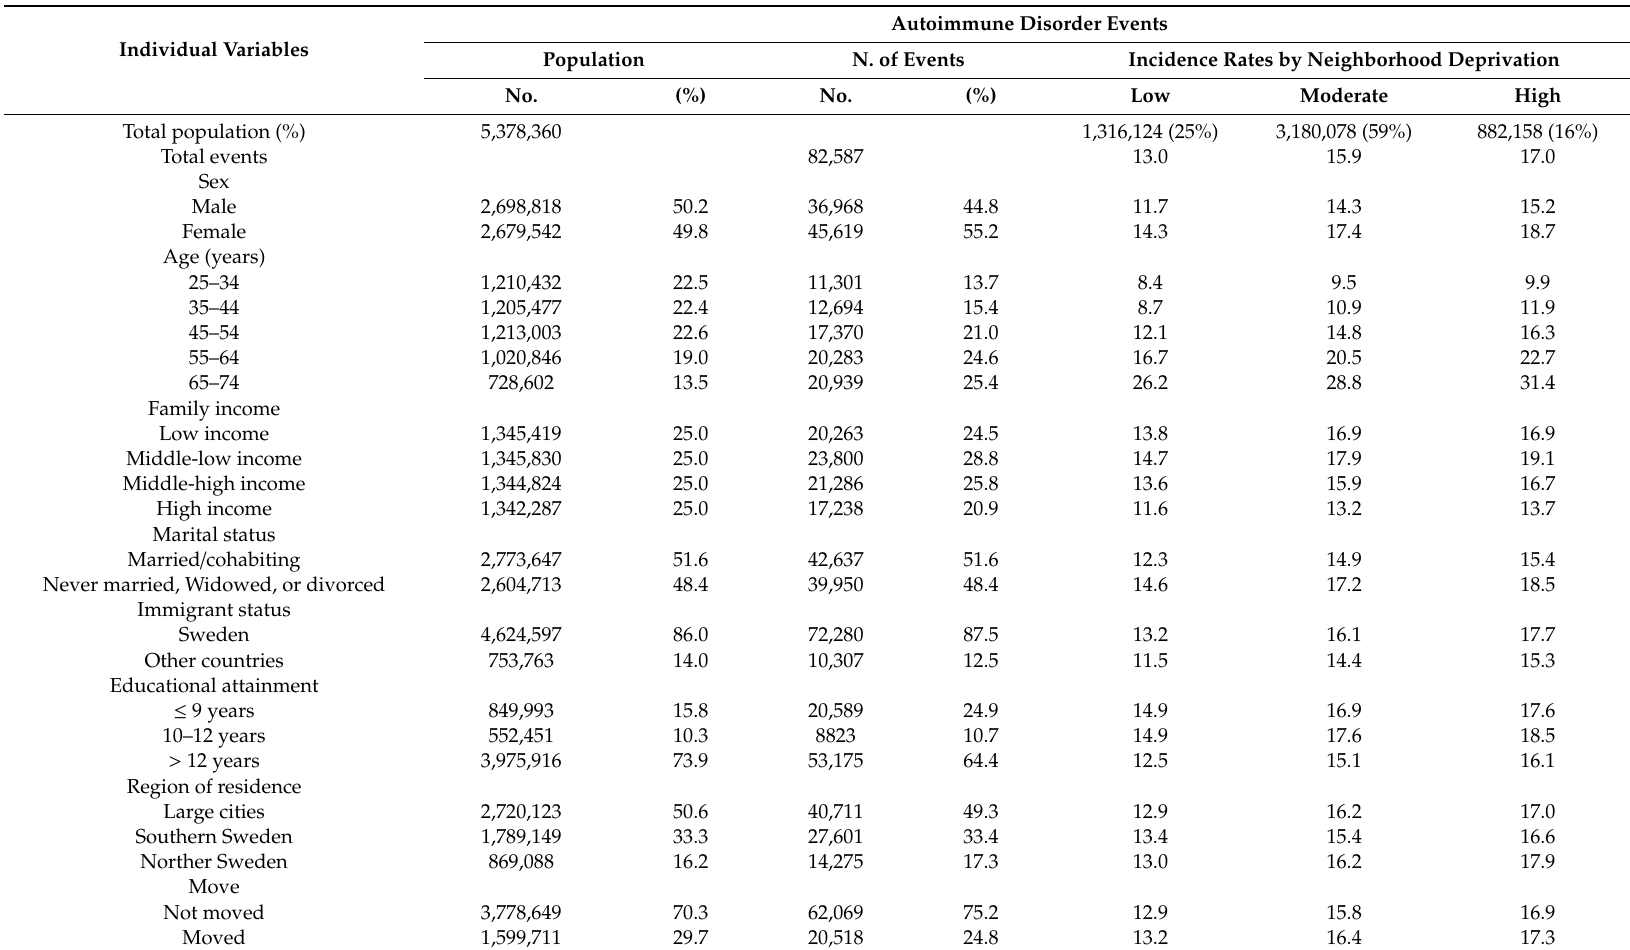
Table 1. Distribution of population, number of autoimmune disorder events, and age-standardized incidence (per 1000) by neighborhood-level deprivation. Individual